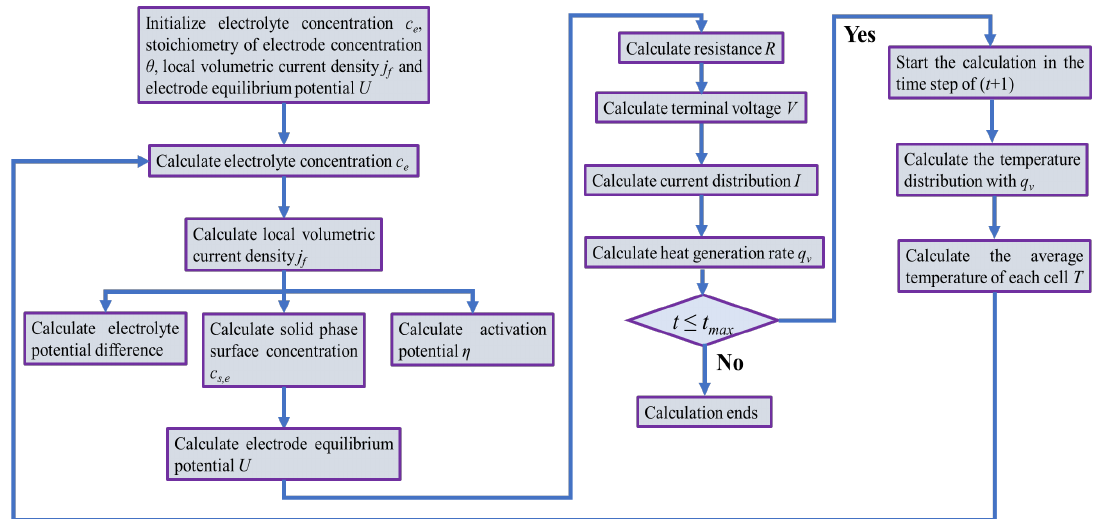
Figure 6. Solution process of electrochemical-thermal model.